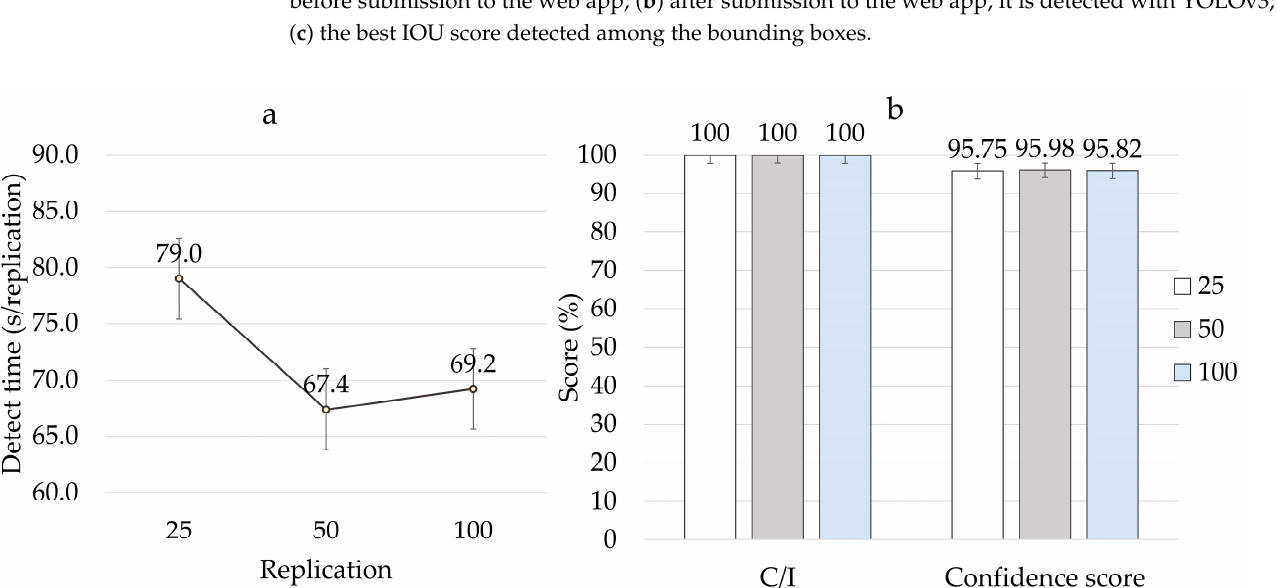
Figure 11. Detection outputs using the application with R. pedestris on the web. ( a ) Original image before submission to the web app; ( b ) after submission to the web app, it is detected with YOLOv3; ( c ) the best IOU score detected among the bounding boxes. Table 2. C/I with a confidence score and run times for iteration.